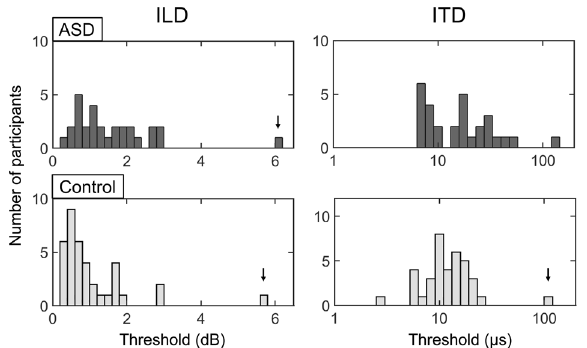
Figure 1. Histograms of ILD and ITD thresholds in ASD and control groups. The arrows indicate outliers.